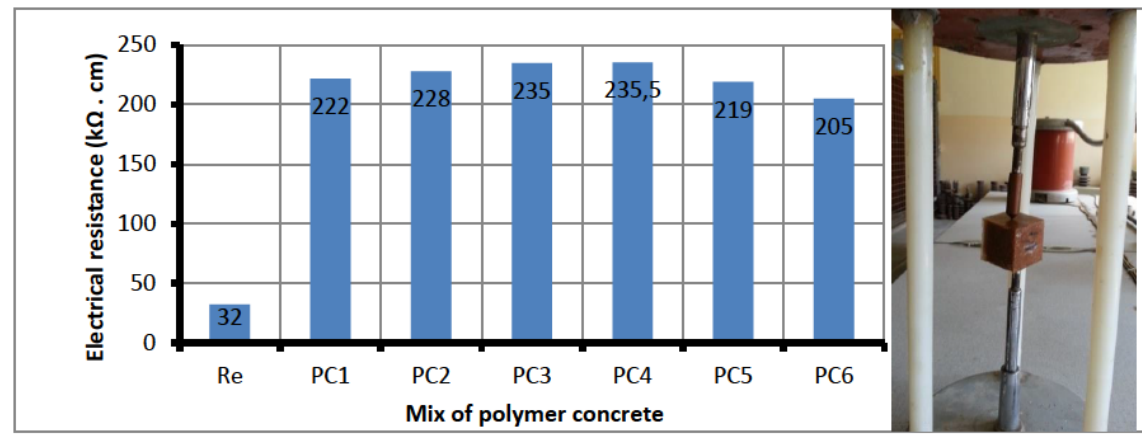
Figure 4: Influence of Sand Size on Electrical Resistance of Polymer Concrete at 28 Age